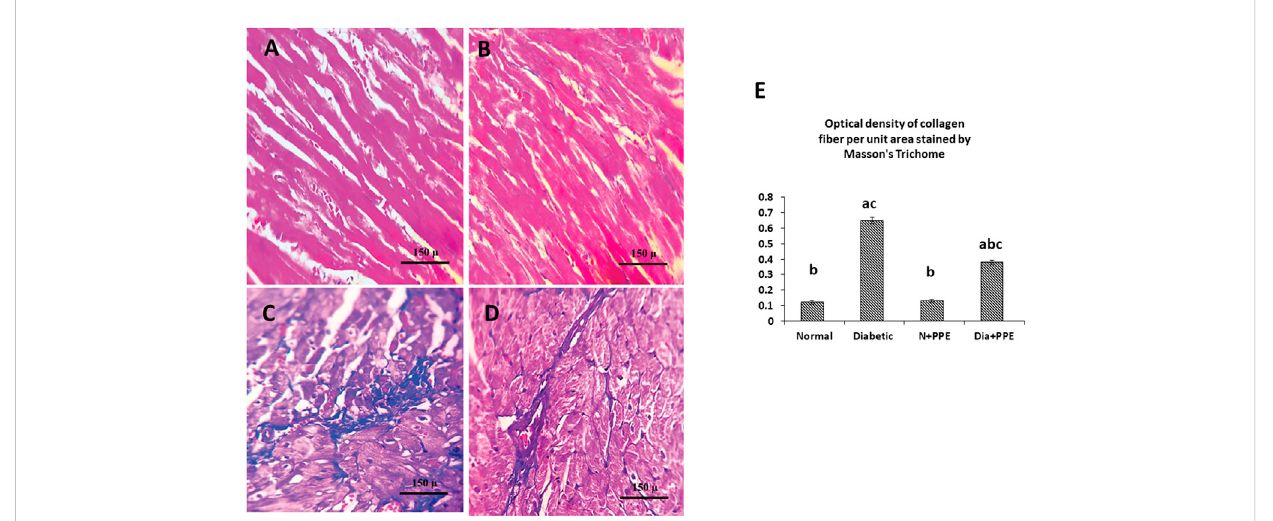
FIGURE 7 Masson ’ strichomestainingofthecardiactissuesofthestudiedratgroups. (A) Cardiactissuefromthenon-diabeticratsinthenegativecontrolgroup showing normal delicate fi brous strand. (B) Cardiac tissue from the non-diabetic rats treated with the pomegranate peel extract showing an appearance similar to that of interstitial collagen as the negative control group. (C) Cardiac tissue from the diabetic rats in the positive control group showing thick fi brous bands. (D) Cardiac tissue from the diabetic rats treated with pomegranate peel extract group illustrating a mild amount of collagen fi bers. (E) Illustrative fi guredemonstratingthequantitativemeasurementoftheopticaldensityofcollagen fi berperunitareastainedbyMasson ’ strichome.Dataare presentedasmean±SD; n =6.Normal:normalrats(negativecontrolgroup).Diabetic:non-treateddiabeticrats(positivecontrolgroup).N+PPE:normal rats treated with the PPE. Dia + PPE: diabetic rats treated with the PPE. a: signi fi cant versus negative control group; b: signi fi cant versus positive control group, c: signi fi cant versus treated normal group; p <